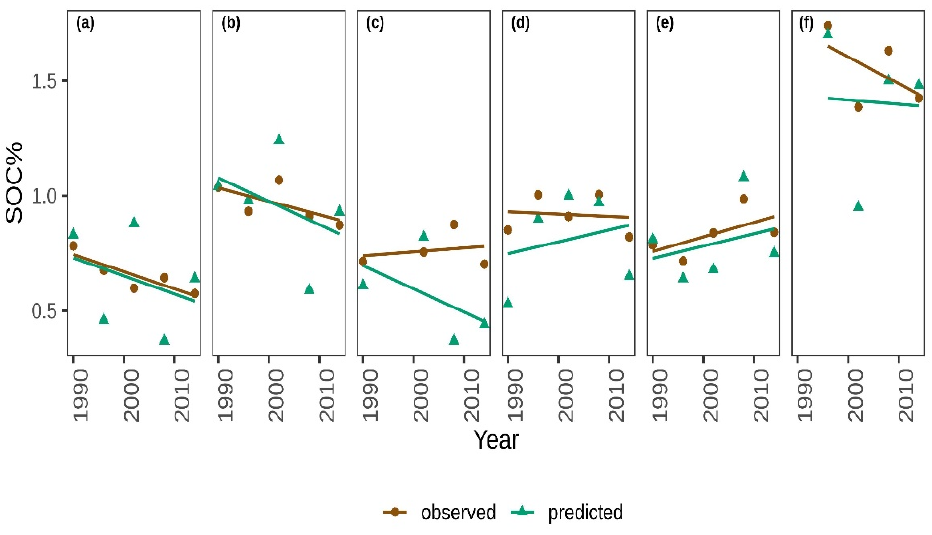
Figure 4. KBS trial treatment by sample year. ( a ) T1, ( b ) T2, ( c ) T3, ( d ) T4, ( e ) T6, ( f ) T8. See Table 1 for treatment description. No significant differences in slopes were detected.